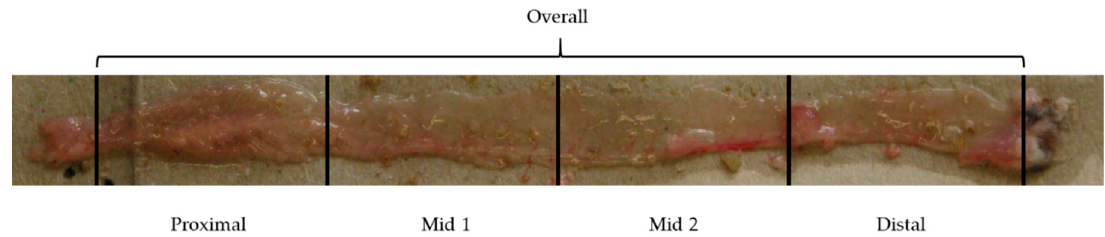
Figure 3. Large intestine of a representative mouse. The large intestine was opened longitudinally and divided into four parts: proximal, mid 1, mid 2, and distal.